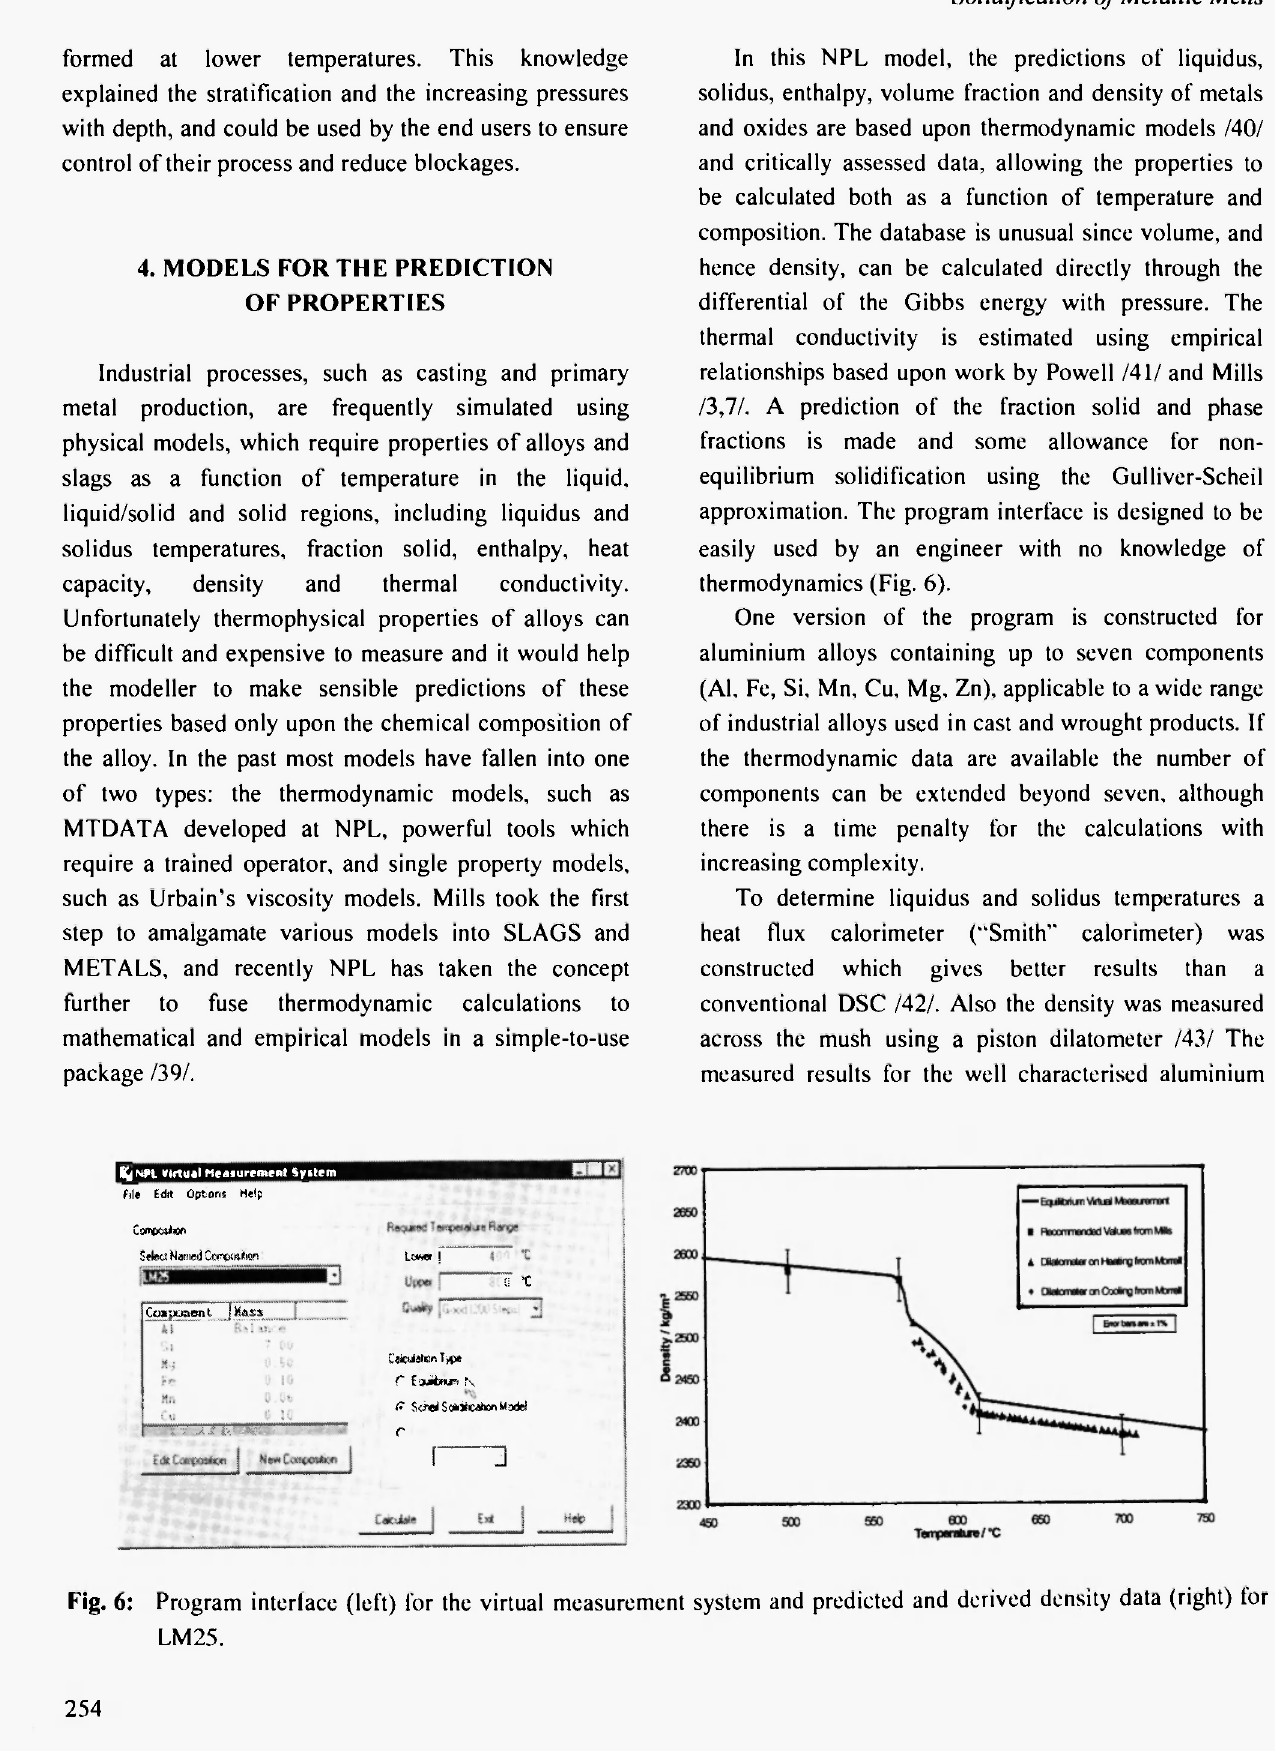
Fig. 6: Program interlace (left) for the virtual measurement system and predicted and derived density data (right) for